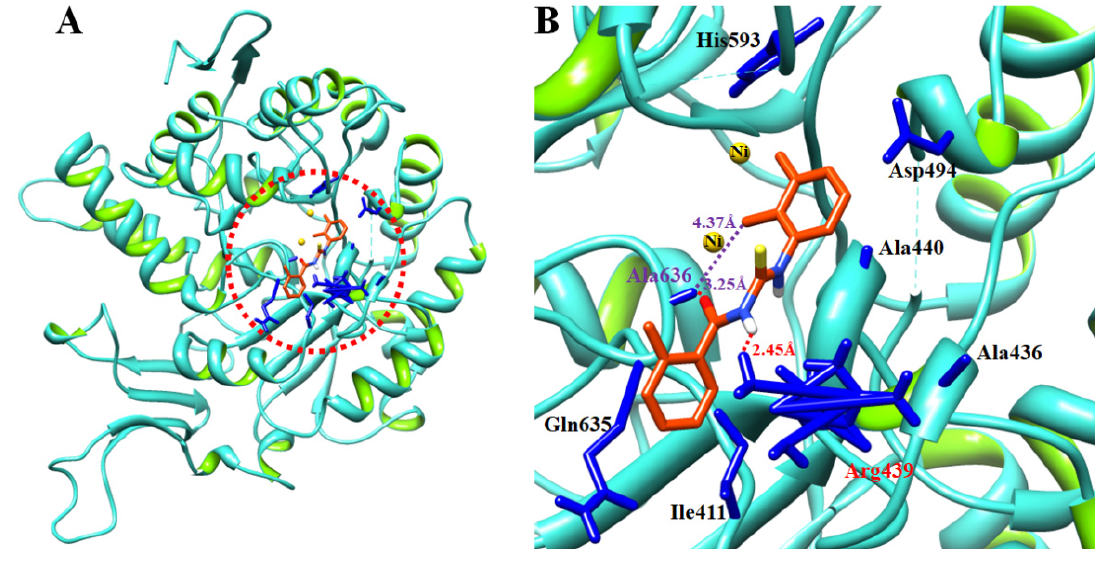
Figure 6. ( A , B ) Docking complex of 4i with jack bean urease [JBU] [4H9M]. The structure of the ligand is indicated in the olive drab colour; yellow represents the two nickel atoms. Two interacted residues Ala636 and Ala436 are highlighted in purple for hydrogen and hydrophobic bonding, respectively. The 2D depiction of docking complexes of synthesized compounds is shown in the supplementary information (Figures S2–S10).